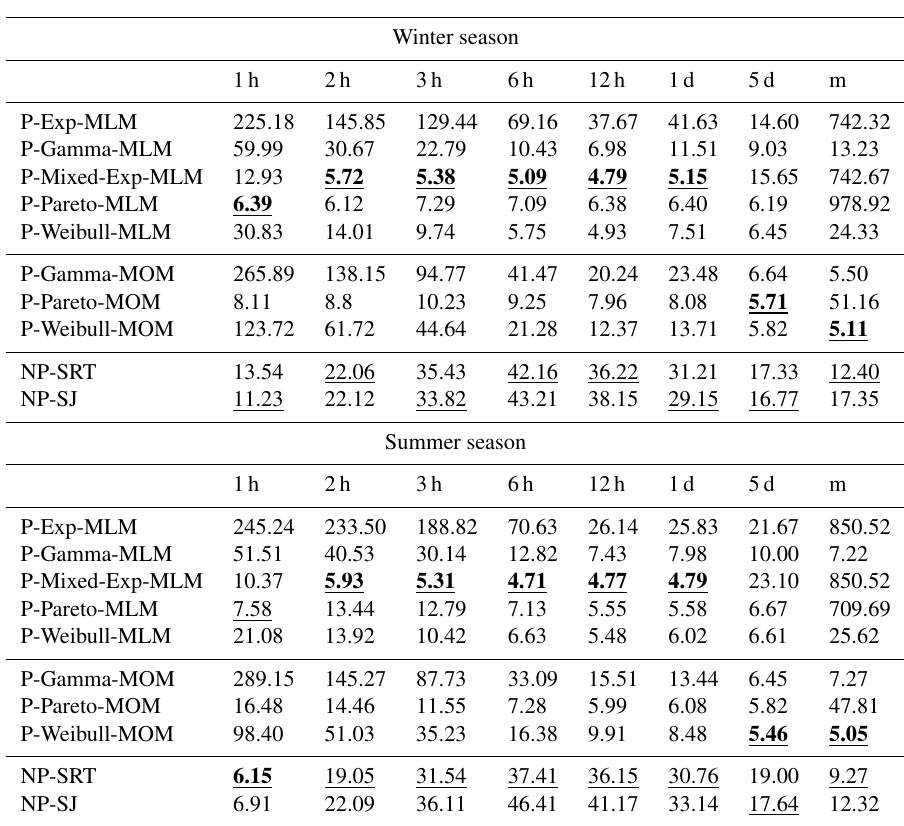
Table 4. The performance ranking numbers of the precipitation amount models for the pointwise estimations. The underlined numbers indicate the best parametric (P) and nonparametric (NP) models. The bold numbers indicate the best overall